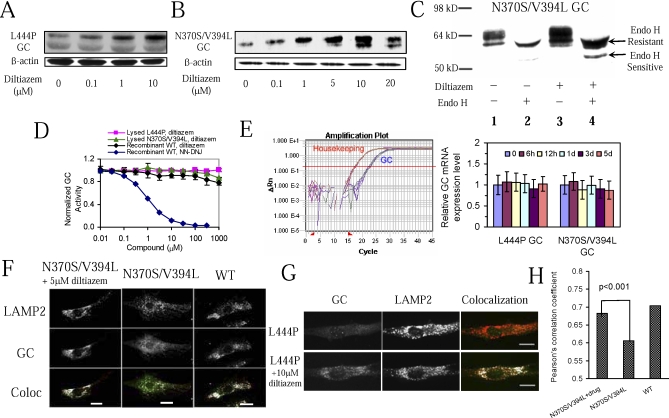
Effect of Diltiazem on L444P and N370S/V394L GC Folding and Trafficking(A) Western blot analysis of untreated and diltiazem-treated L444P GC cells. L444P GC cells were cultured without or with diltiazem at varying concentrations for 7 d before the cells were lysed for SDS-PAGE and Western blot analysis. GC was detected using mouse anti-GC antibody 2E2. β-actin served as a loading control.(B) Western blot of untreated and diltiazem-treated N370S/V394L GC cells. N370S/V394L GC cells were incubated with variable diltiazem concentrations for 7 d before the cells were lysed for SDS-PAGE and Western blot analysis using mouse anti-GC antibody 8E4.(C) The endo-H sensitivity of untreated and diltiazem-treated N370S/V394L GC cells. N370S/V394L GC cells were incubated without and with 10 μM diltiazem for 7 d before the cells were lysed for endo-H digestion, SDS-PAGE, and Western blot analysis using mouse anti-GC antibody 8E4.(D) L444P and N370S/V394L GC cells were lysed and an equal amount of total cell protein was incubated with diltiazem and their GC activities were evaluated using the lysed cell GC activity assay. Cerezyme, a recombinant WT GC protein, was also tested for its GC activity after treatment with diltiazem (black line) or a pharmacological chaperone NN-DNJ, a known inhibitor (blue line).(E) Quantitative RT-PCR on untreated and diltiazem-treated L444P and N370S/V394L GC cells. L444P and N370S/V394L GC cells were incubated with 10 μM diltiazem for 6 h, 12 h, 1 d, 3 d, and 5 d. The figure on the left is the representative amplification plot for the quantitative PCR cycles using L444P GC cells; the figure on the right shows the relative GC mRNA expression level for diltiazem-treated L444P (left entries) and N370S/V394L GC cells (right entries), respectively, which is normalized to that of untreated cells.(F) Immunofluorescence colocalization analysis of GC in N370S/V394L GC and WT fibroblasts. N370S/V394L GC cells were incubated with 5 μM diltiazem for 7 d (column 1) or cultured without drug (column 2). Untreated WT cells were observed as a positive control (column 3). GC was visualized using mouse anti-GC antibody 16B3 (row 2) and rabbit anti-LAMP2 antibody was applied as a lysosomal marker (row 1). In row 3, the colocalization of GC (green) and LAMP2 (red) is shown in white. Bar = 10 μm.(G) Immunofluorescence colocalization analysis of GC in L444P GC cells. L444P GC cells were incubated with 10 μM diltiazem for 14 d (bottom row) or untreated (top row). GC visualization was accomplished using the mouse anti-GC antibody 8E4 (column 1); rabbit anti-LAMP2 antibody was used as a lysosomal marker (column 2). In column 3, the colocalization of GC (green) and LAMP2 (red) is artificially colored white. Bar = 20 μm.(H) Quantification of the colocalization between the GC protein and the lysosomal marker using PCC. Experimental conditions were stated in Figure 2F.